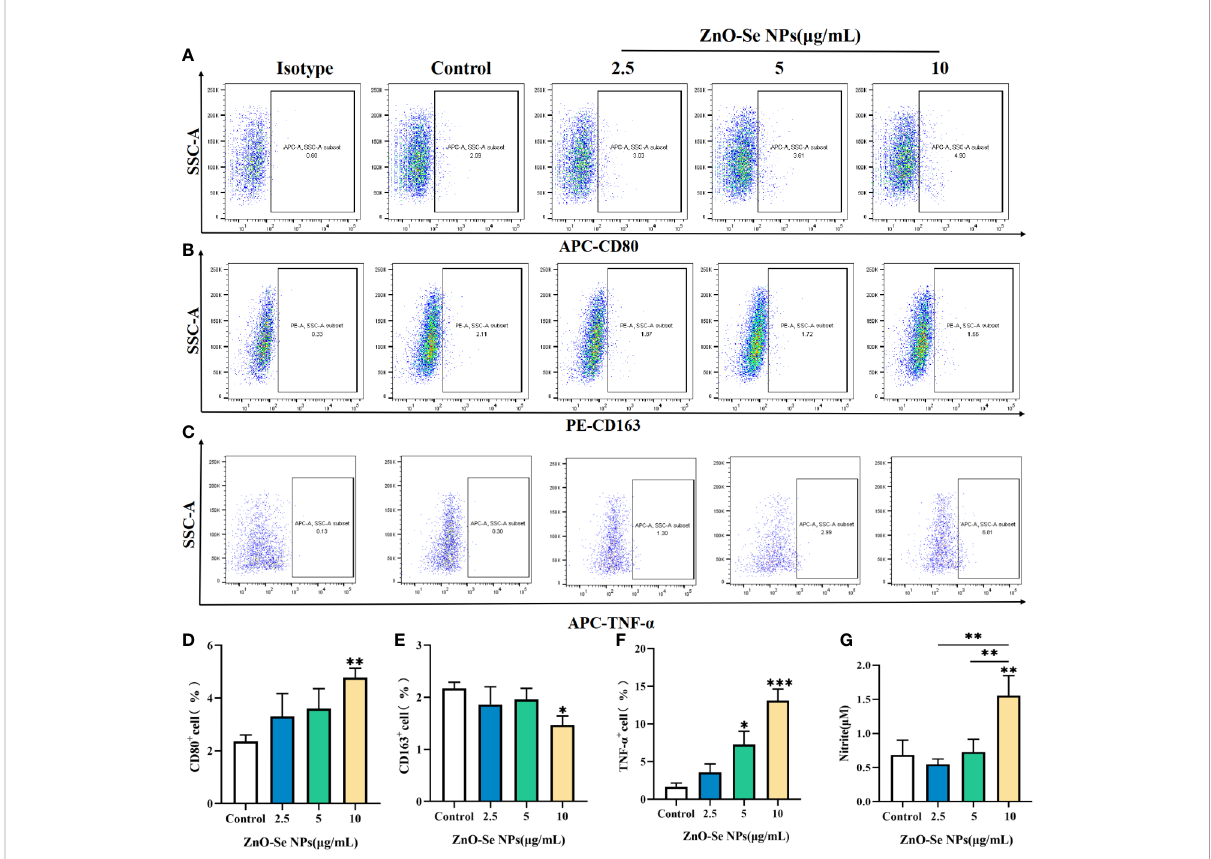
FIGURE 4 Effects of ZnO-Se NPs on the polarization of Mtb infected macrophages. (A – C) Typical fl ow cytometry analysis of (A) CD80 expression, (B) CD163 expression and (C) TNF- a expression in BCG infected THP-1 cells before and after ZnO-Se NPs treatment. (D – F) Statistical results of (D) CD80 expression, (E) CD163 expression and (F) TNF- a expression in BCG infected THP-1 cells before and after ZnO-Se NPs treatment. n=3, *p<0.05, **p<0.01,***p<0.001. (G) Effects of ZnO-Se NPs on the nitrite level in the supernatant of BCG infected THP-1 cells, n=3,